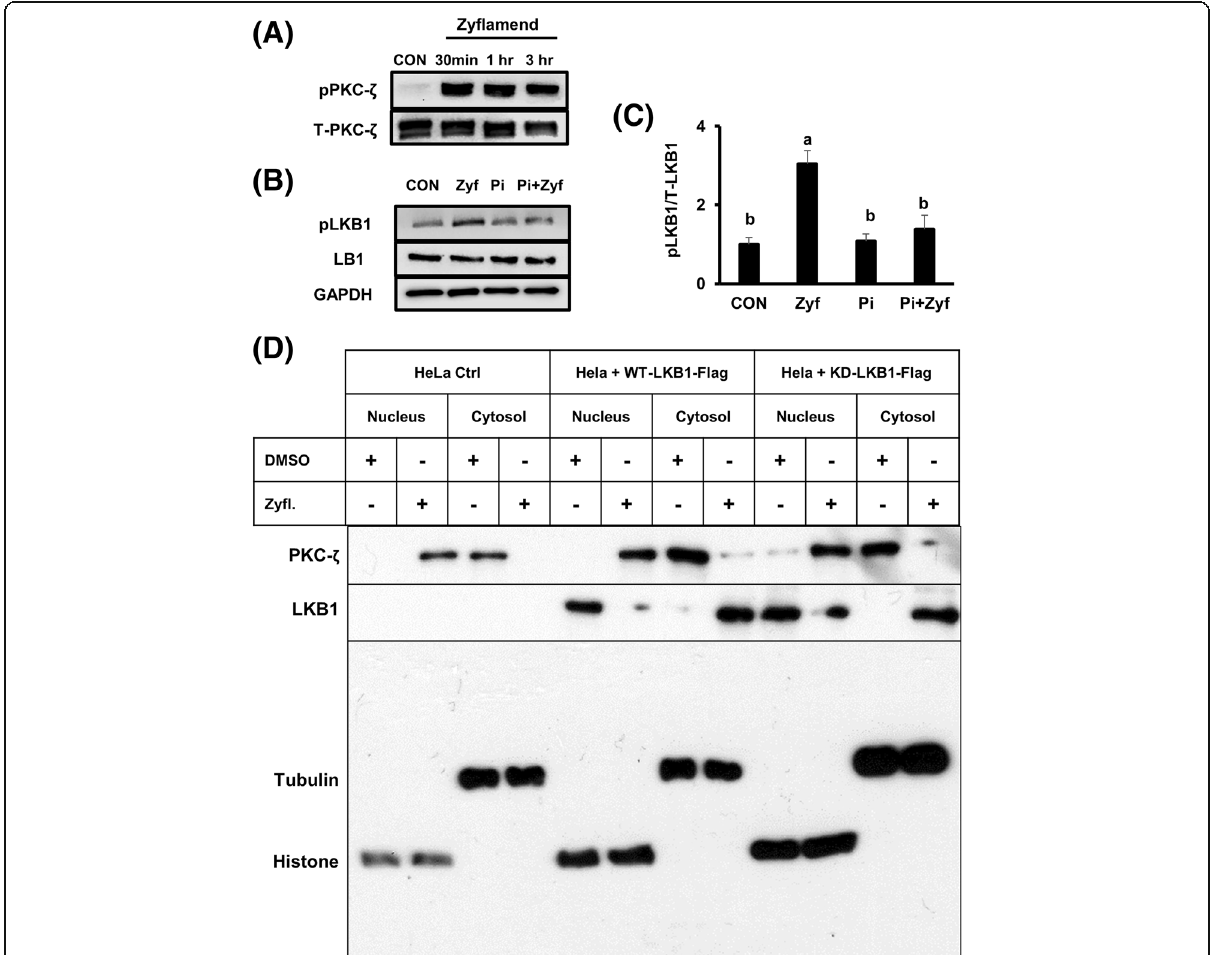
Fig. 7 The effects of Zyflamend on phosphorylation of PKC ζ (at Thr410) and cellular location of PKC ζ and LKB1 in HeLa cells null for LKB1, transfected with wild type (WT) LKB1 or with a catalytically dead (KD) mutant of LKB1. A Western blot of phosphorylation of PKC ζ ± Zyflamend (200 μ g/mL, 30 min – 3 h). B , C Western blot of pLKB1 (at Ser428) following treatment with Zyflamend, PKC ζ inhibitor (5 μ M, 30 min) or pretreatment with the PKC ζ inhibitor plus Zyflamend (200 μ g/mL, 30 min). D Western blot for PKC ζ and LKB1 following subcellular fractionation (cytosol and nucleus) in HeLa cells null for LKB1, transfected with WT LKB1 or with a KD mutant of LKB1 treated with or without Zyflamend (200 μ g/mL, 1 h). Representative immunoblots from 3 independent experiments are shown. Abbreviations: CON, Control; Pi, PKC ζ inhibitor; Zyf,